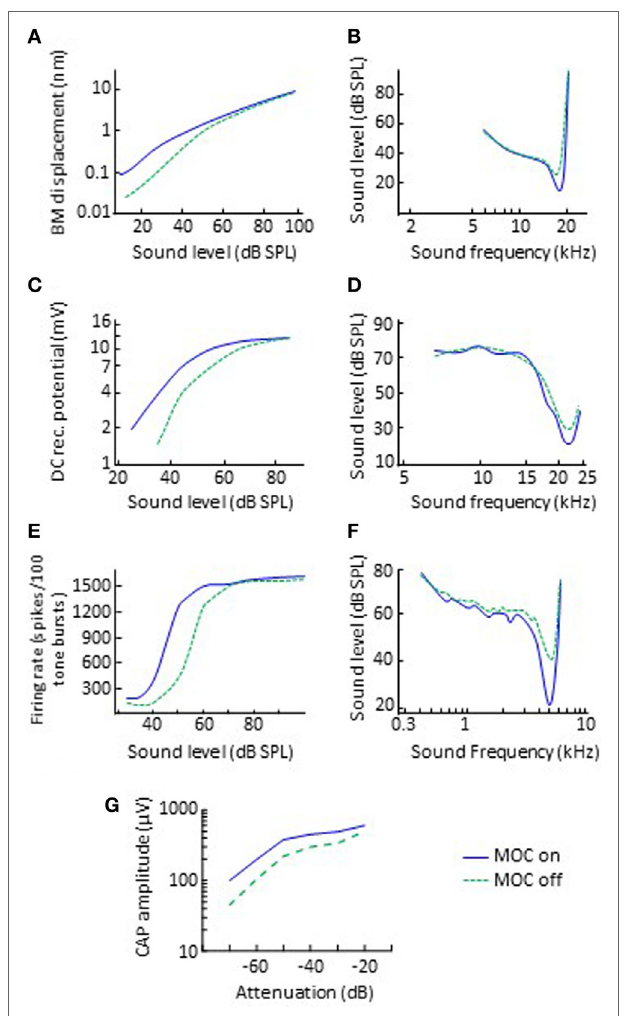
FiGURe 2 | Effects of electrical activation of olivocochlear efferents on various physiological responses to sounds in quiet. The left and right panels illustrate input/output and threshold tuning curves for the corresponding system, respectively. (A,B) Basilar motion. Data re-plotted, in modified form, from Cooper and Guinan (33). (C,D) Inner hair cell receptor potential. Data re-plotted, in modified form, from Brown and Nuttall (34). (e,F) Discharge of single auditory nerve afferent fibers. Data in panels (e,F) are re-plotted, in modified form, from Wiederhold (35) and Guinan and Gifford (36), respectively. (G) Auditory nerve CAP. Data re-plotted, in modified form, from Elgueda et al. (37). Abbreviations: BM, basilar membrane; CAP, compound action potential; DC, direct current; MOC, medial-olivocochlear